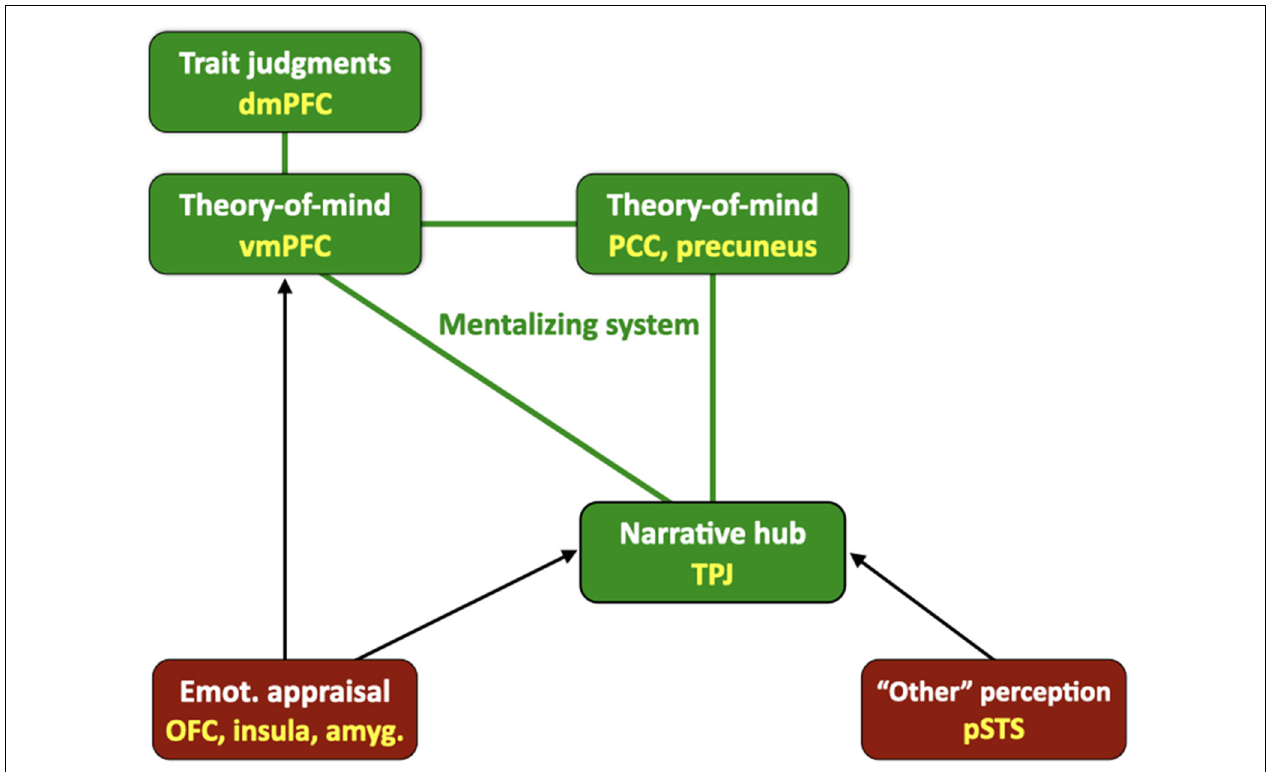
FIGURE 5 | A neural model of the “who” system of the human brain. While “who” processing involves all facets of sensory processing about physical features and movement across the five major senses, the core of the who system is a network for character processing. It maps onto systems for mentalizing, trait processing, emotion perception, and emotional appraisal. The mentalizing components include the ventromedial prefrontal cortex (vmPFC), posterior cingulate cortex (PCC), precuneus, and the cortex of the temporoparietal junction (TPJ), which acts as a hub that interfaces areas for processing emotional appraisals [orbitofrontal cortex (OFC), insula, and amygdala (amyg.)] and the perception of emotional expression (the posterior superior temporal sulcus, pSTS), as well as episode processing for plot-schemas that is not shown in the figure. Trait processing includes areas in the dorsomedial prefrontal cortex (dmPFC). Components of the mentalizing system are shown in green, while sensory and emotion areas are shown in red. The figure is oriented anatomically such that the left side of the figure corresponds with the anterior part of the brain. Abbreviation: Emot.,